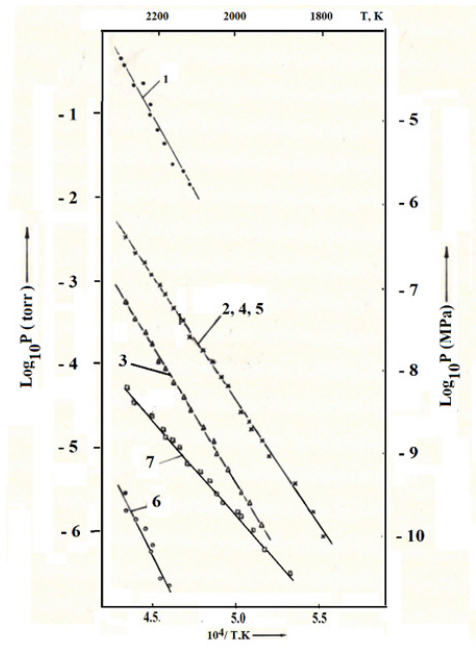
Figure 3. Dependence of partial pressures of gas phase components on temperature in Arrhenius coordinates over composition of sample 3 in Table 2 or No. 15 in Table 5: 1—nitrogen, 2,4,5—uranium, 3—uranium monoxide, 6—uranium mononitride, 7—uranium